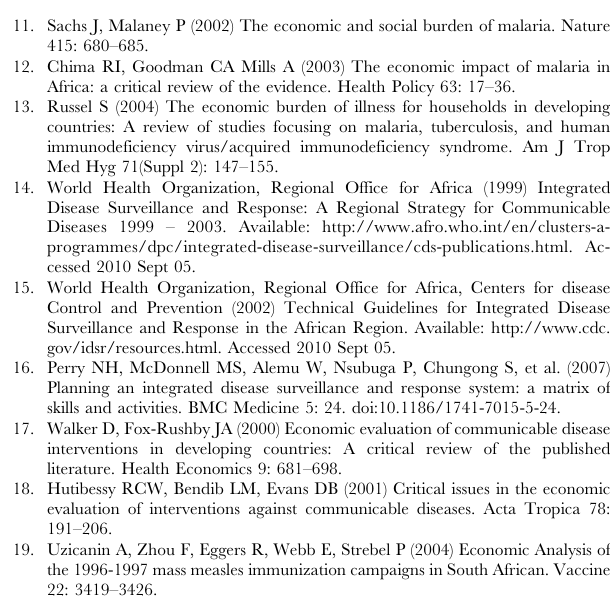
Table S3 Pattern of annual vaccines imported into Burkina Faso before (1996–2002) and after (2003–2008) IDSR implementation.